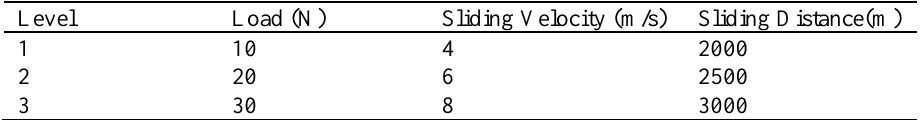
Table 2. Chemical composition of Al6061-T6 Level Load (N) Sliding Velocity (m/s) Sliding